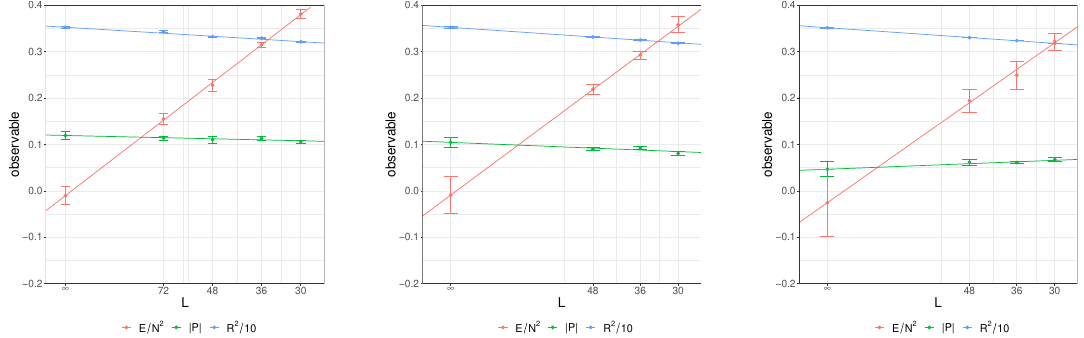
Figure 28. Full BFSS (i.e., full BMN with µ = 0 ) at temperature T = 0 . 2 . From left to right: continuum extrapolation (lattice size L → ∞ ) for matrix size N = 10 , 12 , 16 . The horizontal axis scales as 1 /L . We can see that the continuum extrapolation of E is consistent with zero for all N 2 values of N . Therefore, E is consistent with zero in the simultaneous continuum and large- N limits. N 2 We note that for the simulation with parameters L = 30 , N = 16 , we discarded configurations with a too-large value of R 2 due to the run-away behavior. We show alternative plots and discuss the reasoning in appendix